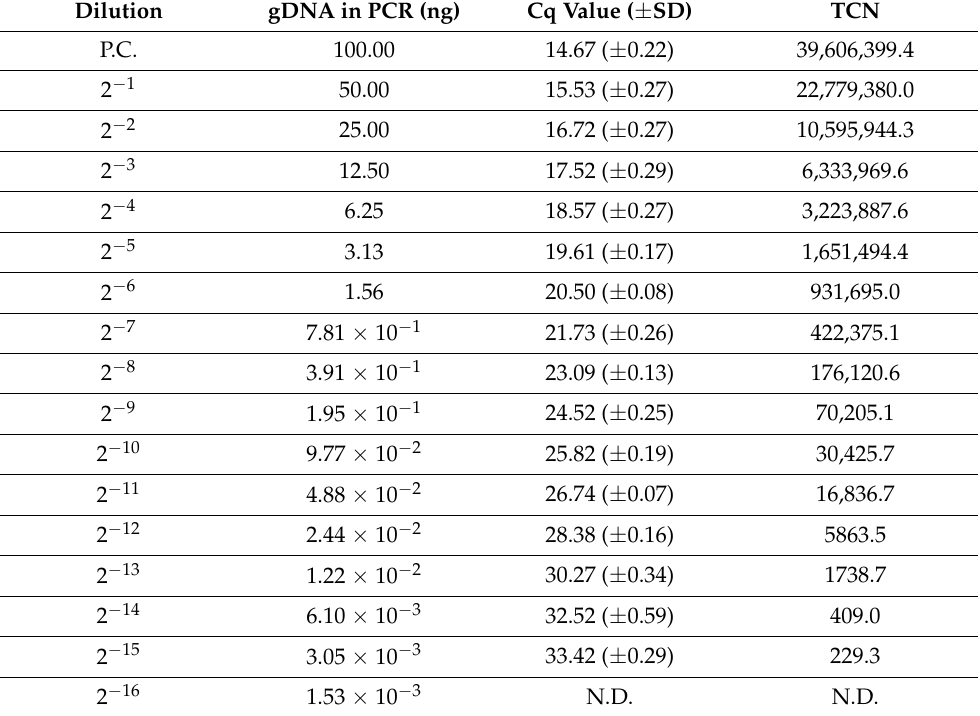
Table 2. Sensitivity of the Fusarium spp.-specific qPCR assay using a serial dilution of gDNA from F. oxyporum f. sp radicis-lycopersici . The lowest amount of detection for both assays can be observed. Data are expressed as quantification cycle (Cq) values and target copy number (TCN). P.C.: